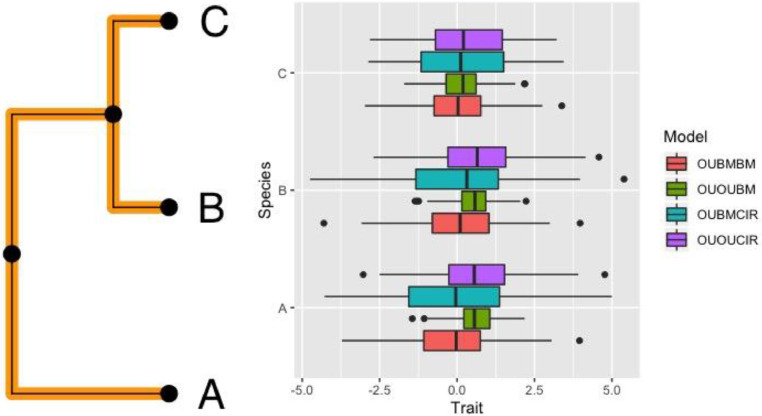
Boxplots for tips simulated under the models of adaptive trait evolution using trait simulator in ouxy. The R script to generate the plots for this simulation can be accessed at online supplement compTraitsim.R